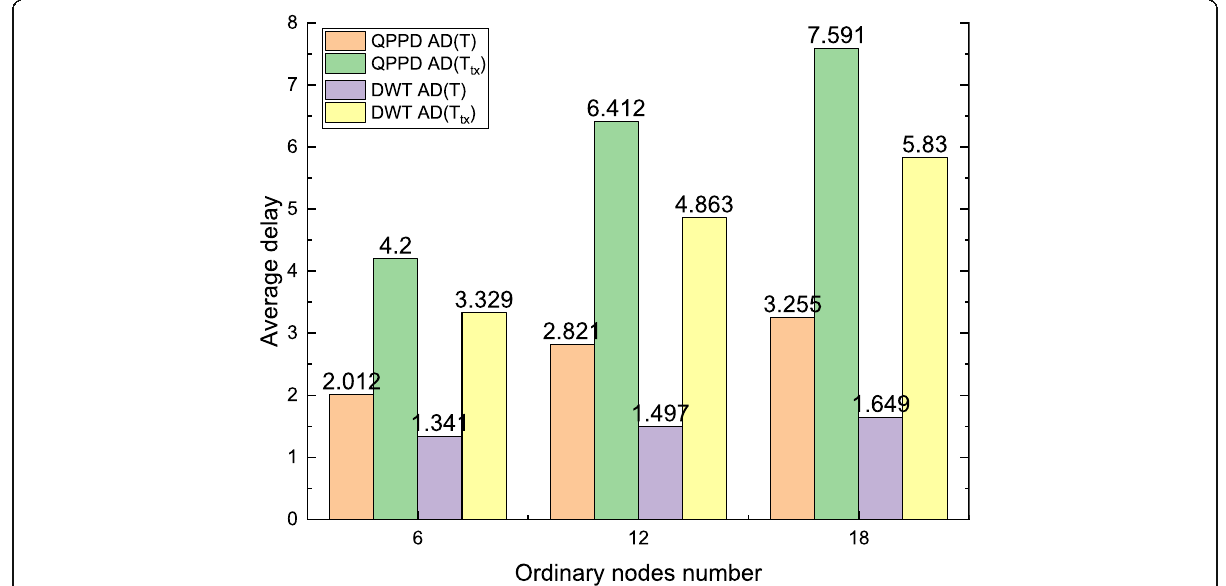
Fig. 20 The total number of periodic data changes increases from 0 to 18; the average delay of highest priority